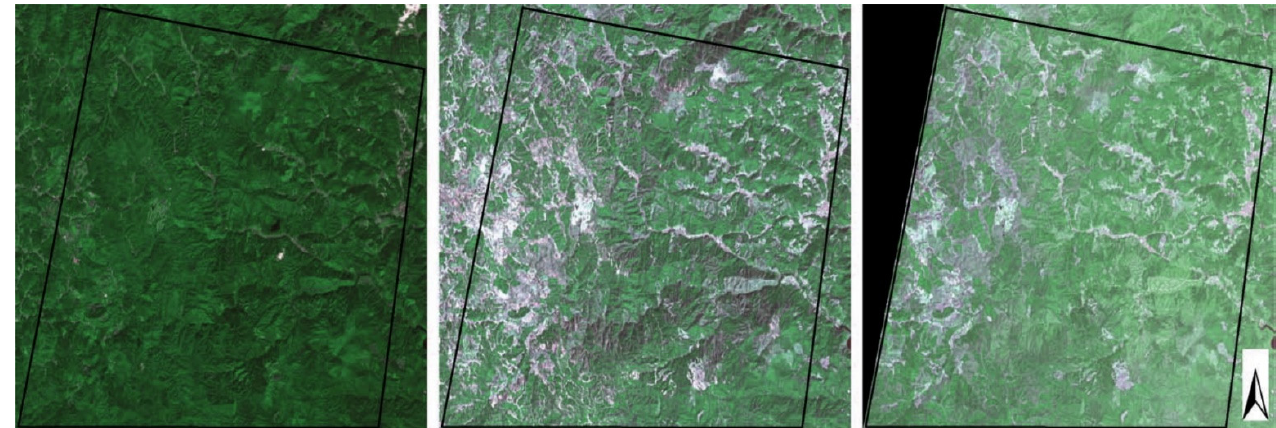
Figure 1. Typical ASTER images for image classification [images courtesy of